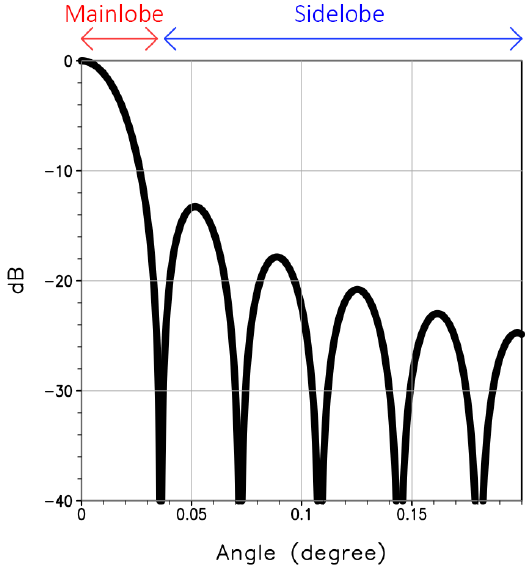
Figure 1. Beam pattern (dB) as a function of beam direction angle (degree).